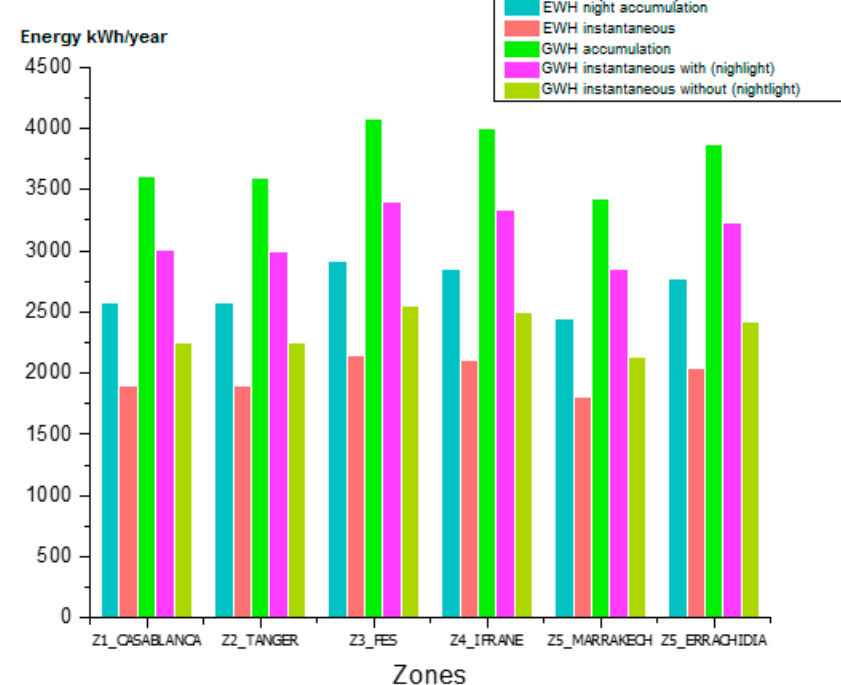
Figure 13. SWH production energy for low demand.